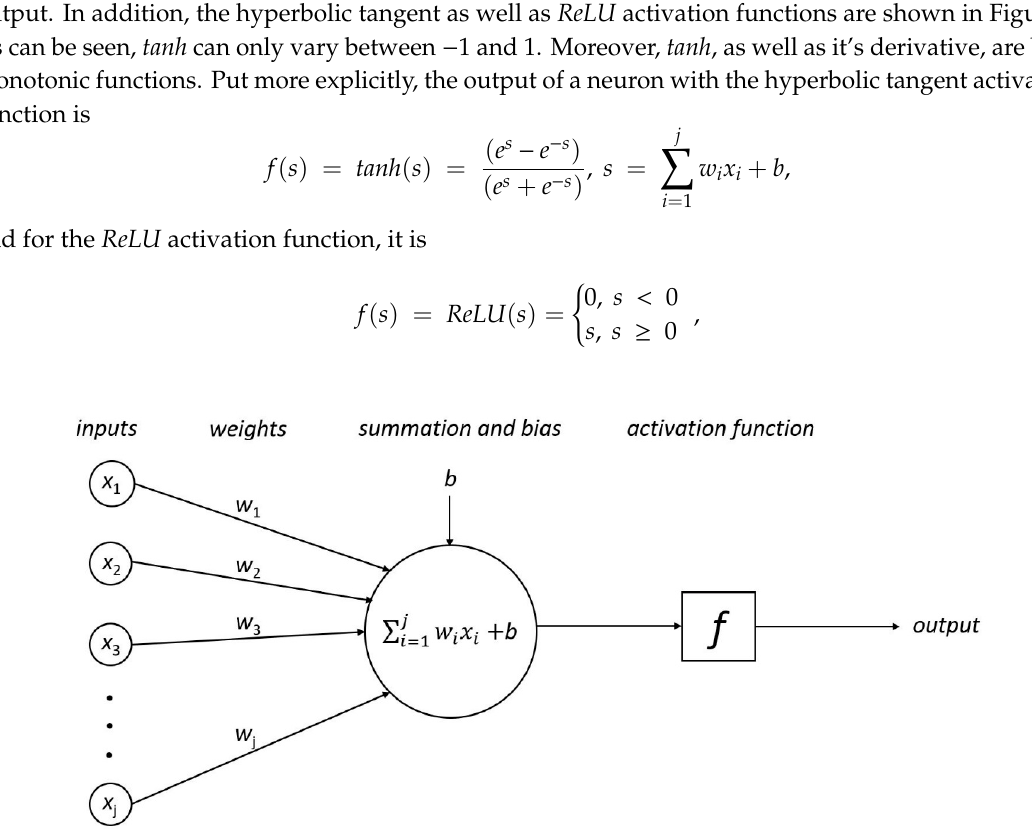
Figure 2. A schematic representation of a single neuron.